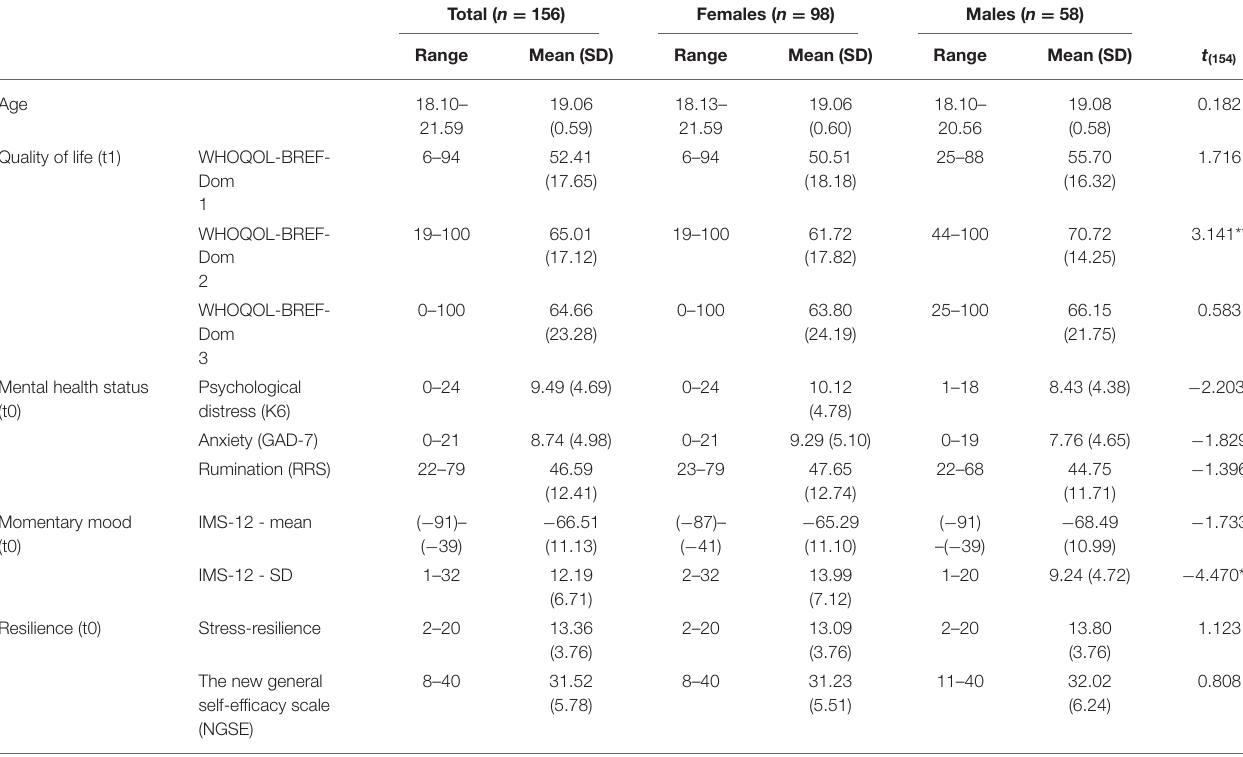
TABLE 1 | Descriptive statistics of demographic variables and outcome measures in the study